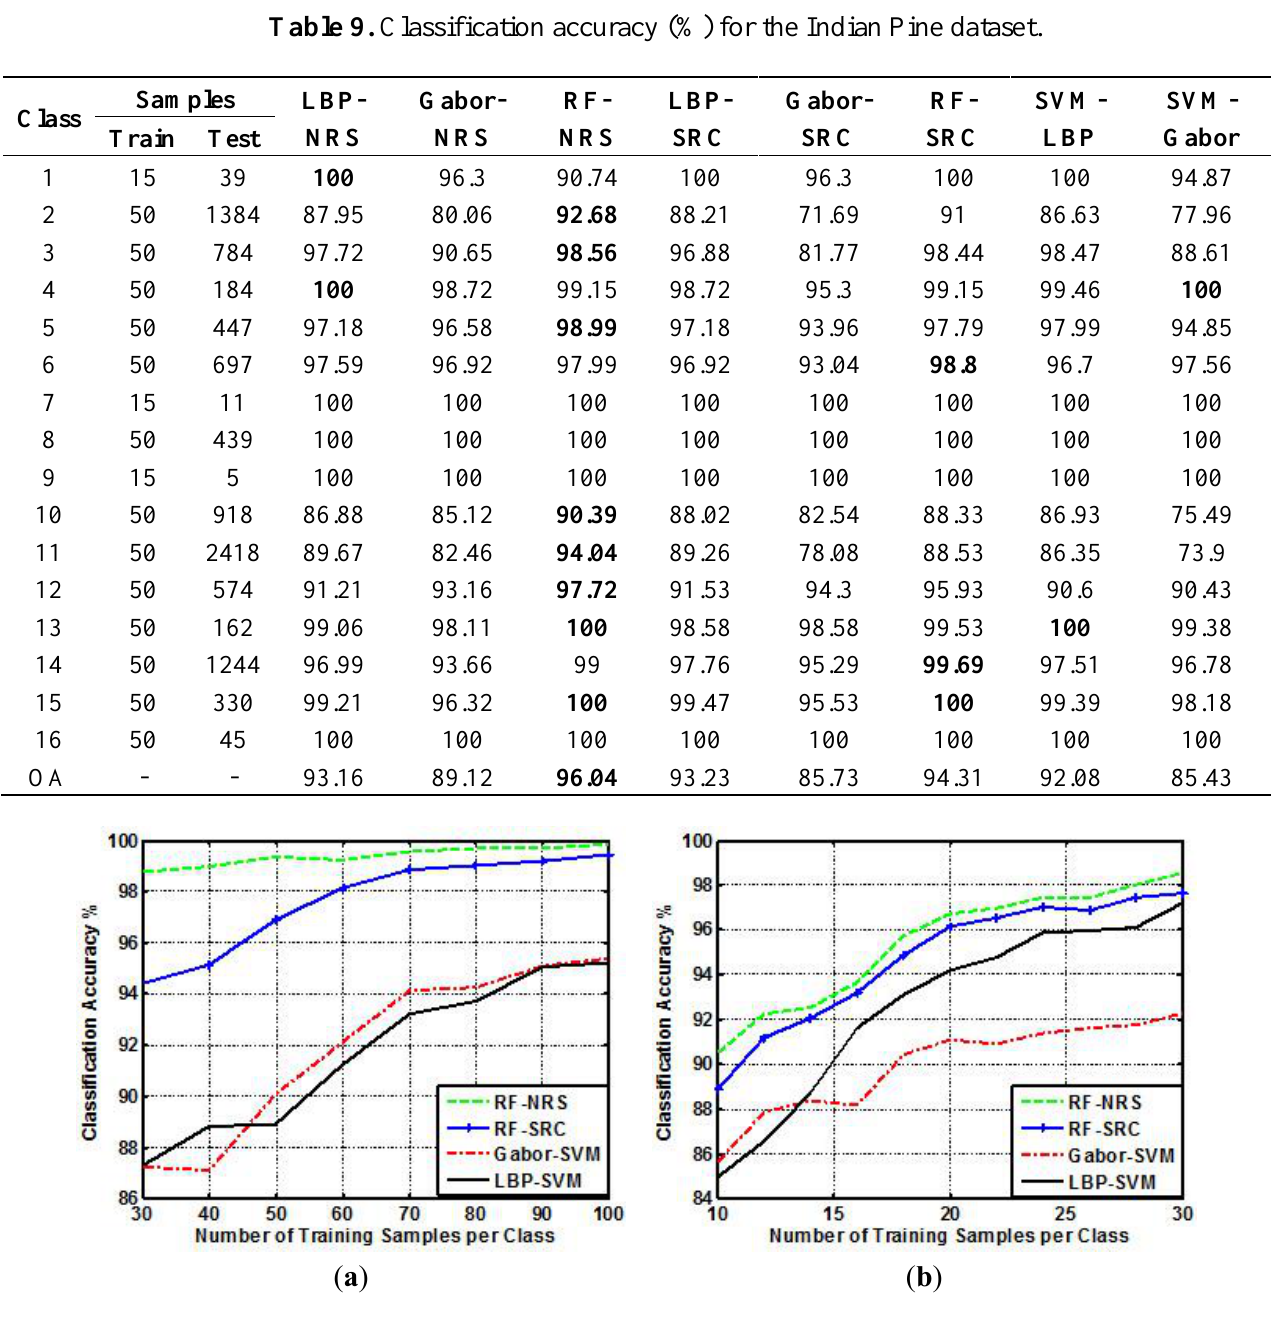
Figure 10. Classification accuracy (%) versus the number of training samples per class for: ( a ) University of Pavia dataset; ( b ) Salinas